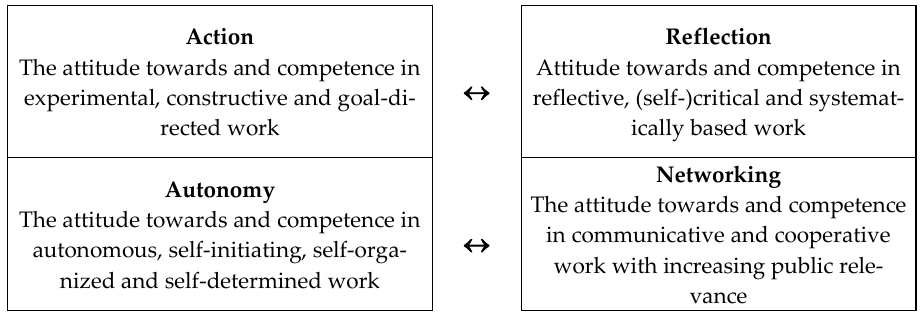
Figure 1. Dimensions of teacher´s professional practice (schematized by the authors of this article according to Krainer [36]). according to Krainer